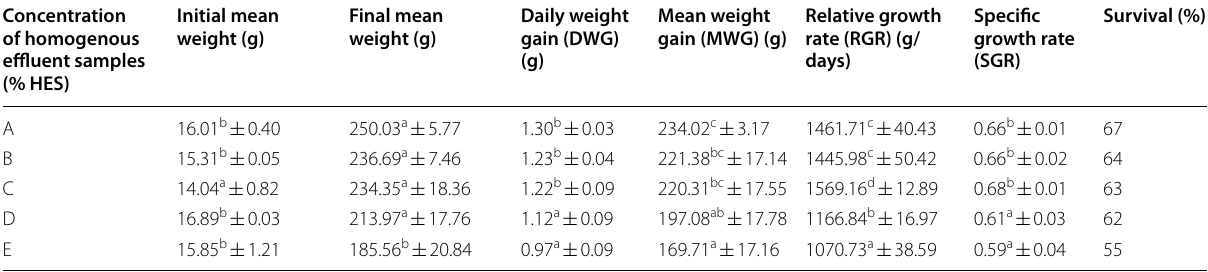
A—control; B—0.32%; C—0.66%; D—1.31%; E—2.63% *Values with different superscripts within the same column are significantly different at p < 0.05